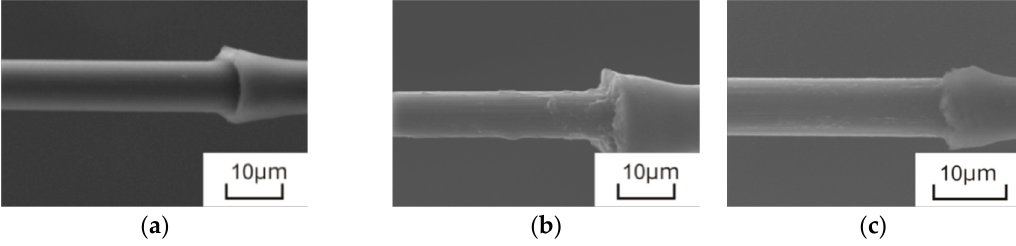
Figure 8. SEM images of pulled-out carbon fibers: ( a ) Dry-As-received-CF; ( b ) Dry-CNT–CF; ( c ) Wet-CNT–CF.